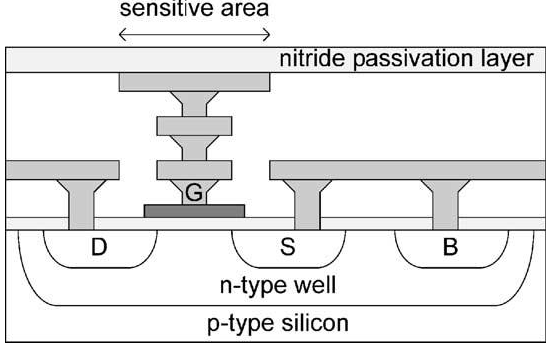
Figure 5. A floating gate EOS (Electrolyte-Oxide-Semiconductor) FET. The FET gate, G,